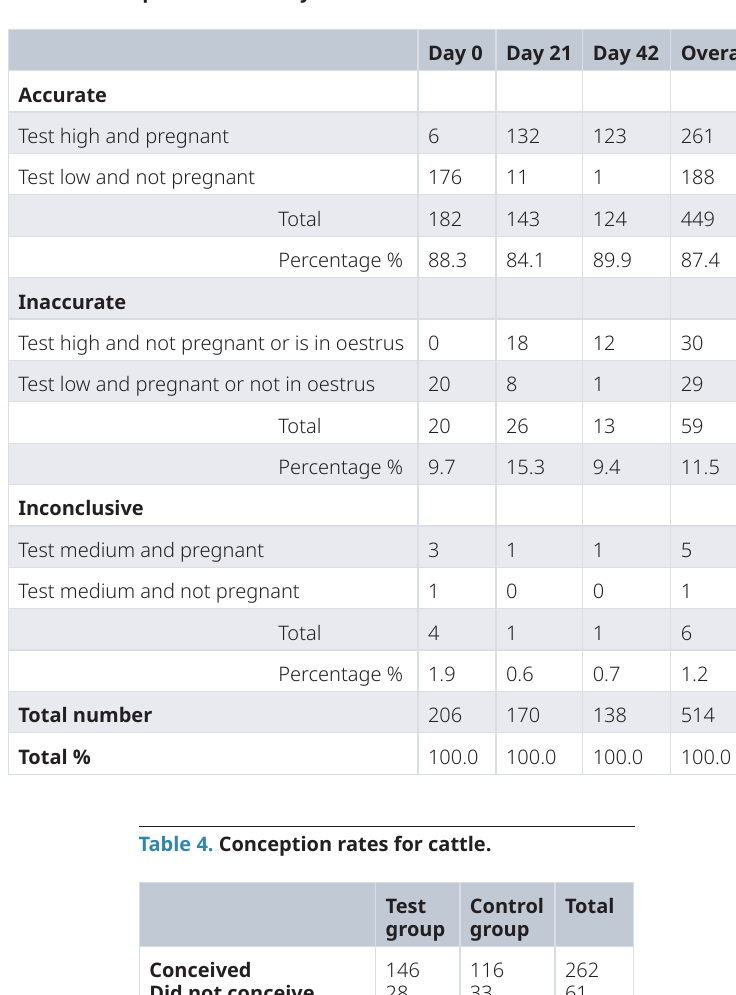
Table 3. P4 Rapid test accuracy – worst-case scenario.